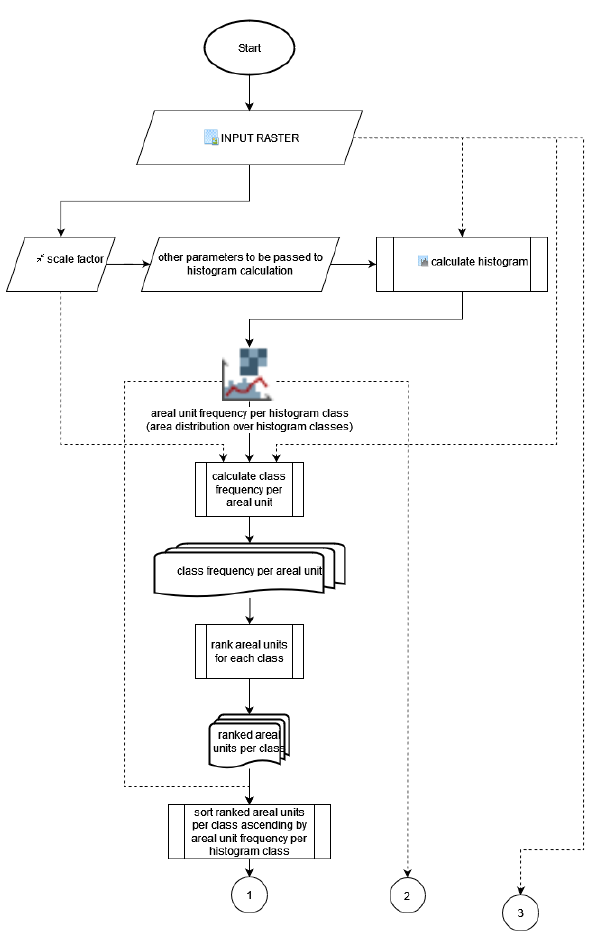
Figure A1. Flowchart of the novel downsampling method part